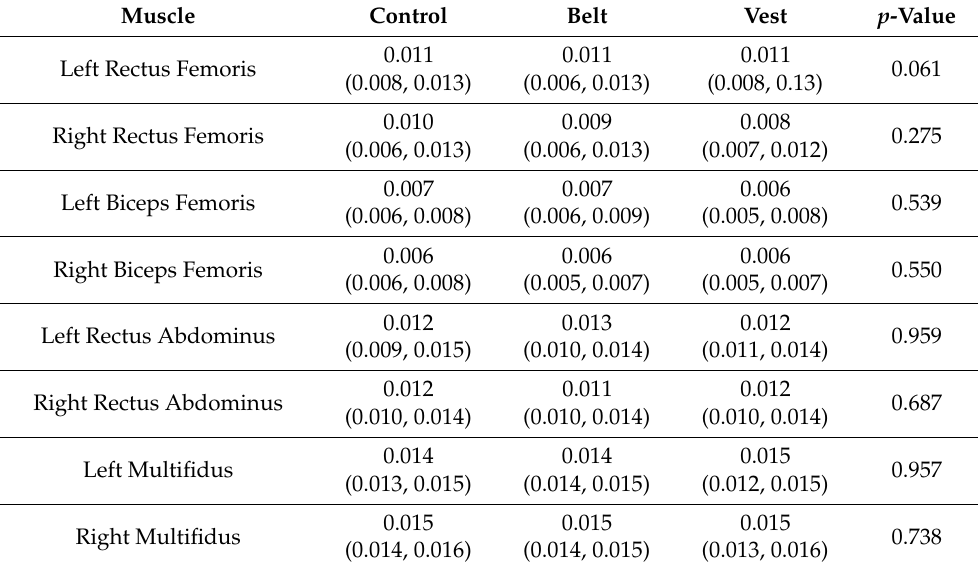
Figure 4. Comparison of muscle activity between conditions while walking. Values are medians and interquartile range in the bracket computed on data from all subjects. * denotes statistical difference compared to control. Table 1. Sample entropy of muscles between conditions while walking.